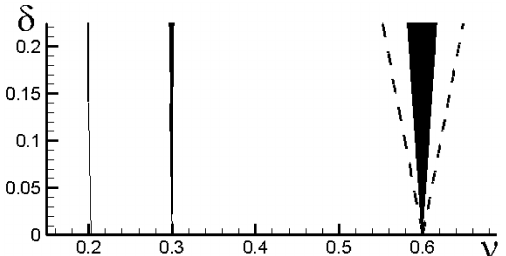
Figure 2. The regions of parametric instability in the parametric plane ( ν, δ ) for e 0 = 0 . 15, γ 0 = 0 . 02. The dark regions correspond to locally unbounded dynamics of the ellipse obtained with the use of the linear approximation (Eq. 7). The dashed lines mark the re- gion incurred from the analytical estimate (Eq.